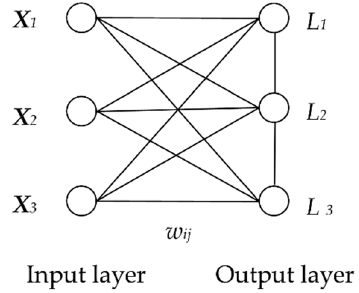
Figure 11. The KNN structure used in this paper.